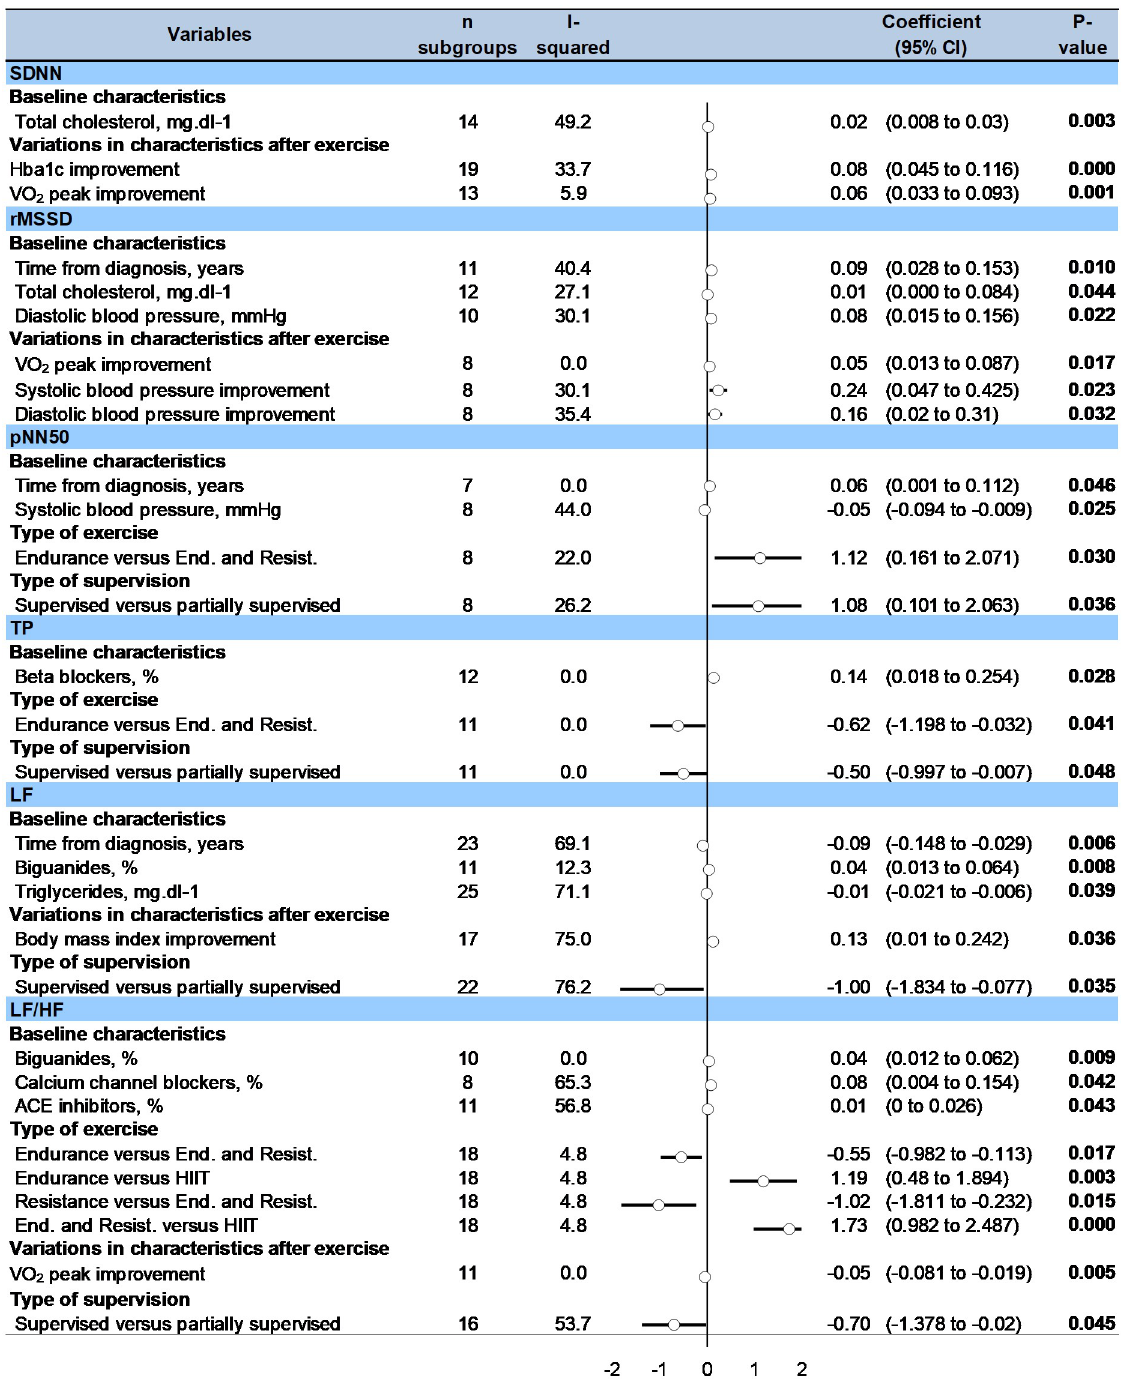
Fig 4. Metaregressions on factors influencing the effect of exercise training on HRV parameters in T2DM patients.